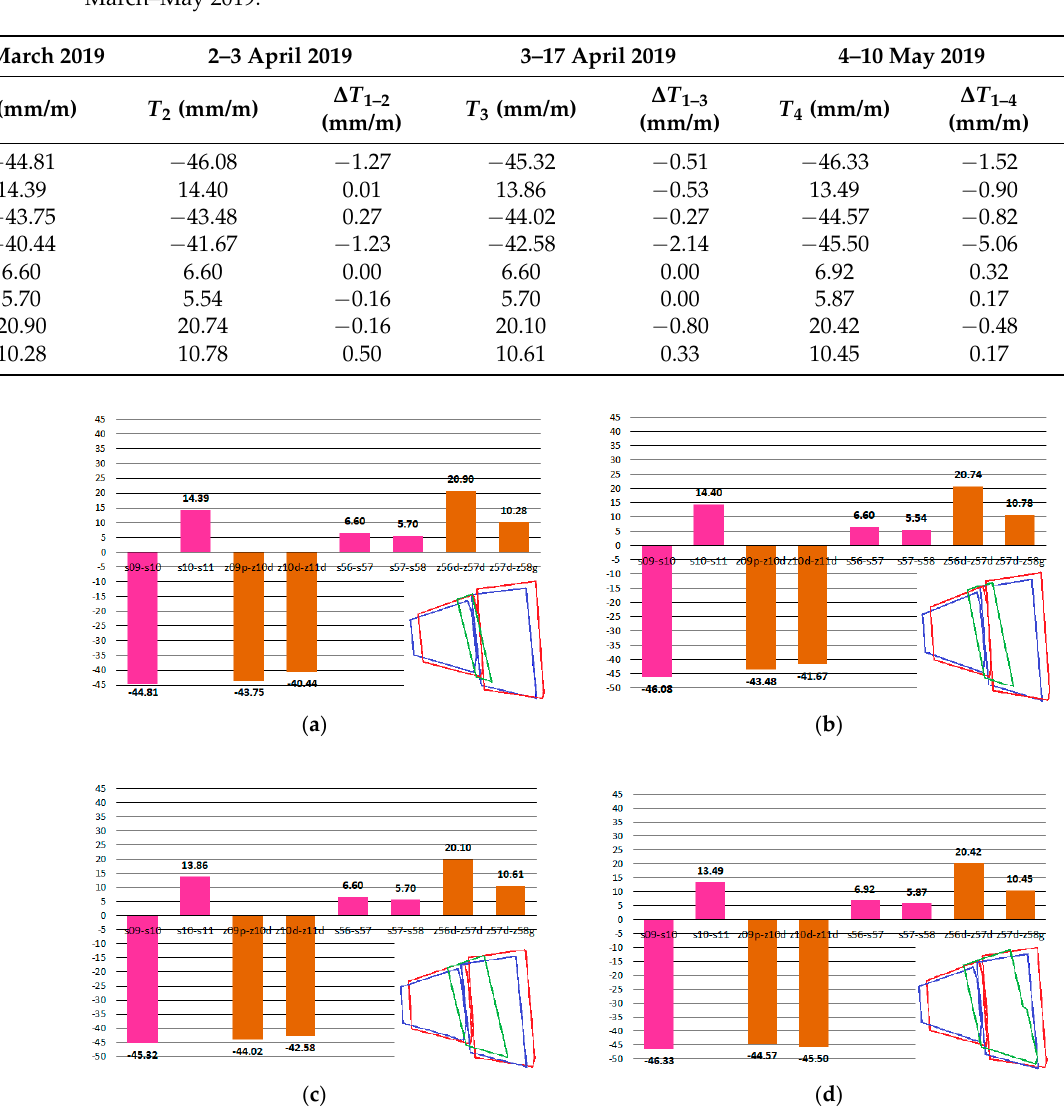
Table 3 and Figure 8 present the values of inclinations from March 19. Table 3. The values of inclinations and their changes observed on the sections in the time period of